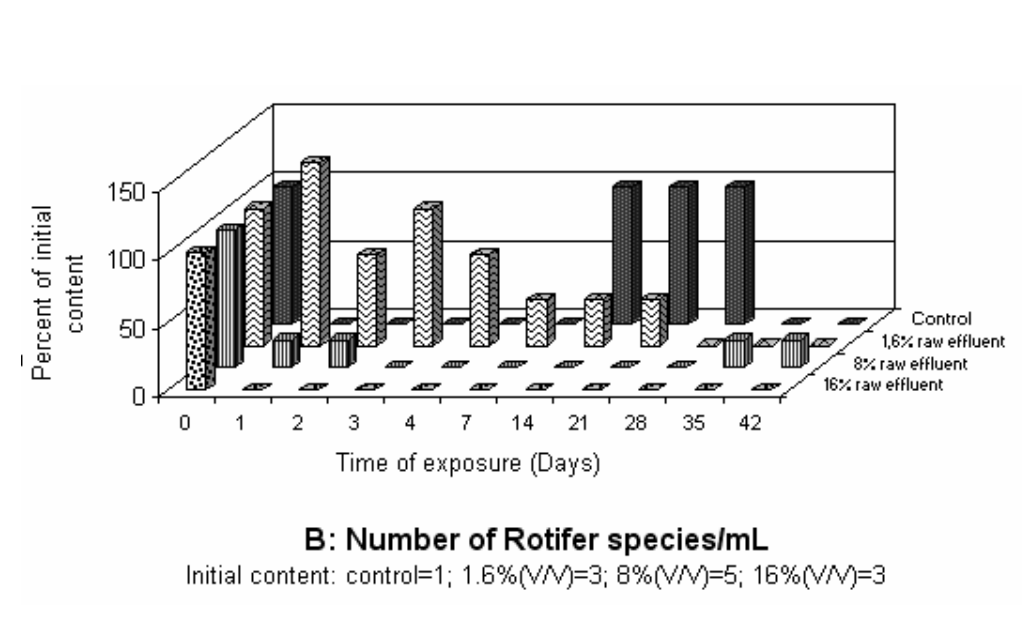
Figure 4: The effect of Pilcam effluent on the protozoan species (A: Ciliates; and B: Rotifers) richness and composition from